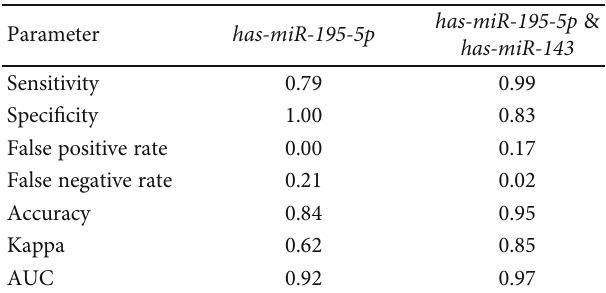
Table 1: Statistical parameters of has-mir-195-5p combined with has-mir-143 to distinguish lung cancer and